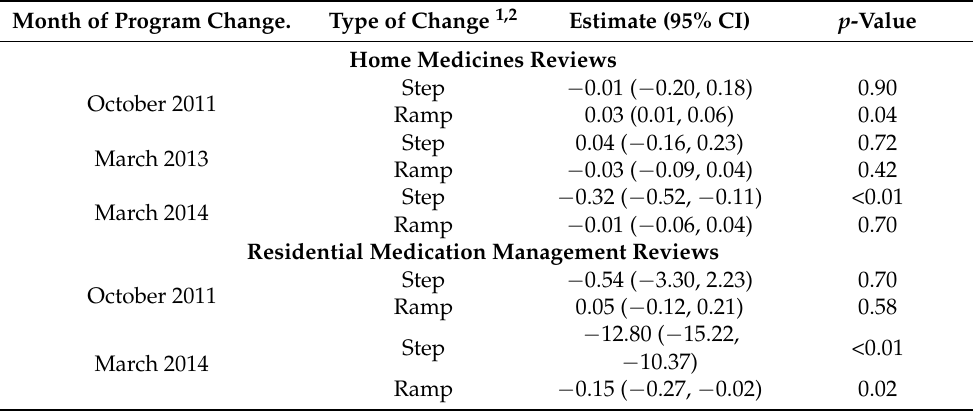
Table 2. Step and ramp estimates from ARIMA